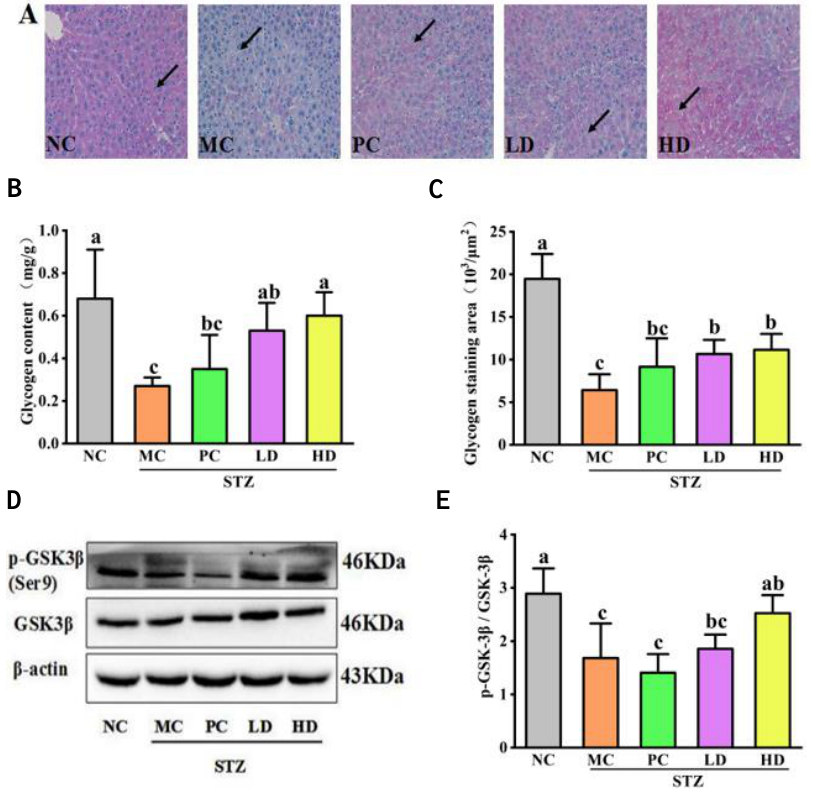
Figure 4. Effect of EPS103 on hepatic glycogen synthesis in the T2DM mice induced by STZ and HFD. ( A ) PAS staining of liver. Scale bars = 100 μm. ( B ) Glycogen content. ( C ) Glycogen staining area. ( D ) Bands of GSK-3 β and p - GSK-3 β (Ser9). ( E ) Protein expression levels of phosphorylated GSK-3 β . β -actin was utilized as loading control. Data are presented as the mean ± SD (n = 3). Different letters indicate statistically significant differences between two groups ( p < 0.05).